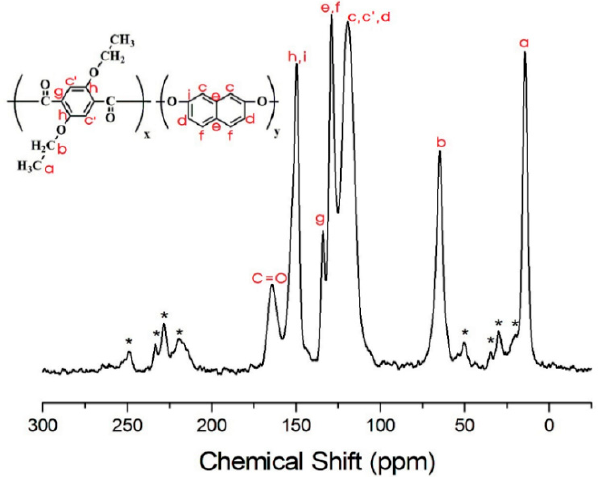
Figure 10. 13 C-NMR chemical shifts of sample I-F at room temperature. In the chemical formula, x:y:z = 1:1:5. The spinning sidebands are marked with asterisks.